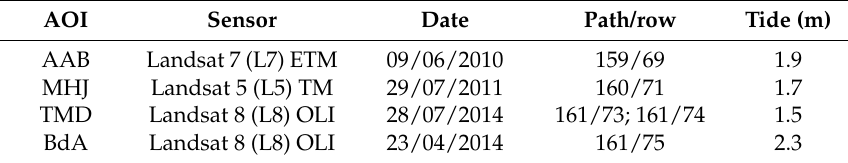
Table 1. Summary of single-date Landsat scenes used for detailed, contemporary mapping of the four AOIs. Maps produced for Ambaro-Ambanja Bays (AAB) and Mahajamba Bay (MHJ) are originally described in Jones et al. [25] and Jones et al. [61]; whereas maps produced for Tsiribihina-Manambolo Delta (TMD) and Baie des Assassins (BdA) result from this study. Tide (m) indicates the average tidal height above mean sea level in or near the AOI during image acquisition. AOI Sensor Date Path/row Tide (m) AAB Landsat 7 (L7) ETM 09/06/2010 159/69 1.9 MHJ Landsat 5 (L5) TM 29/07/2011 160/71 1.7 TMD Landsat 8 (L8) OLI 28/07/2014 161/73; 161/74 1.5 BdA Landsat 8 (L8) OLI 23/04/2014 161/75